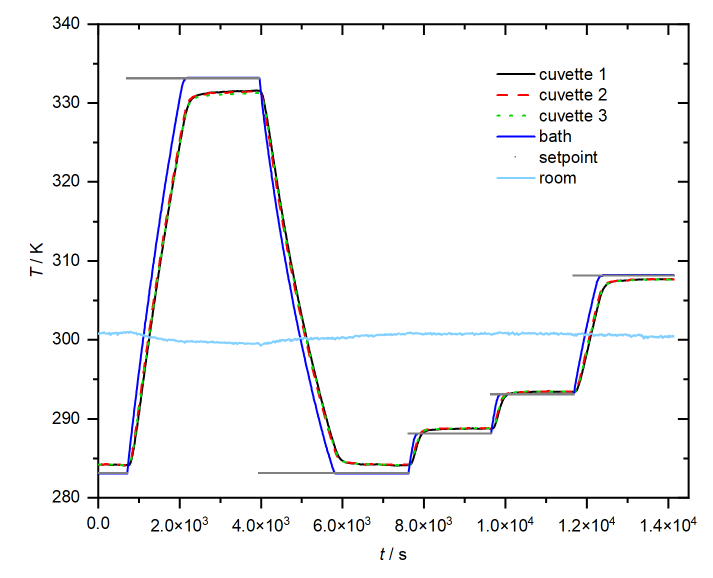
Figure 2. Comparison of set-point temperature, bath temperature and the temperature in three different cuvettes inside the sample holder plotted against